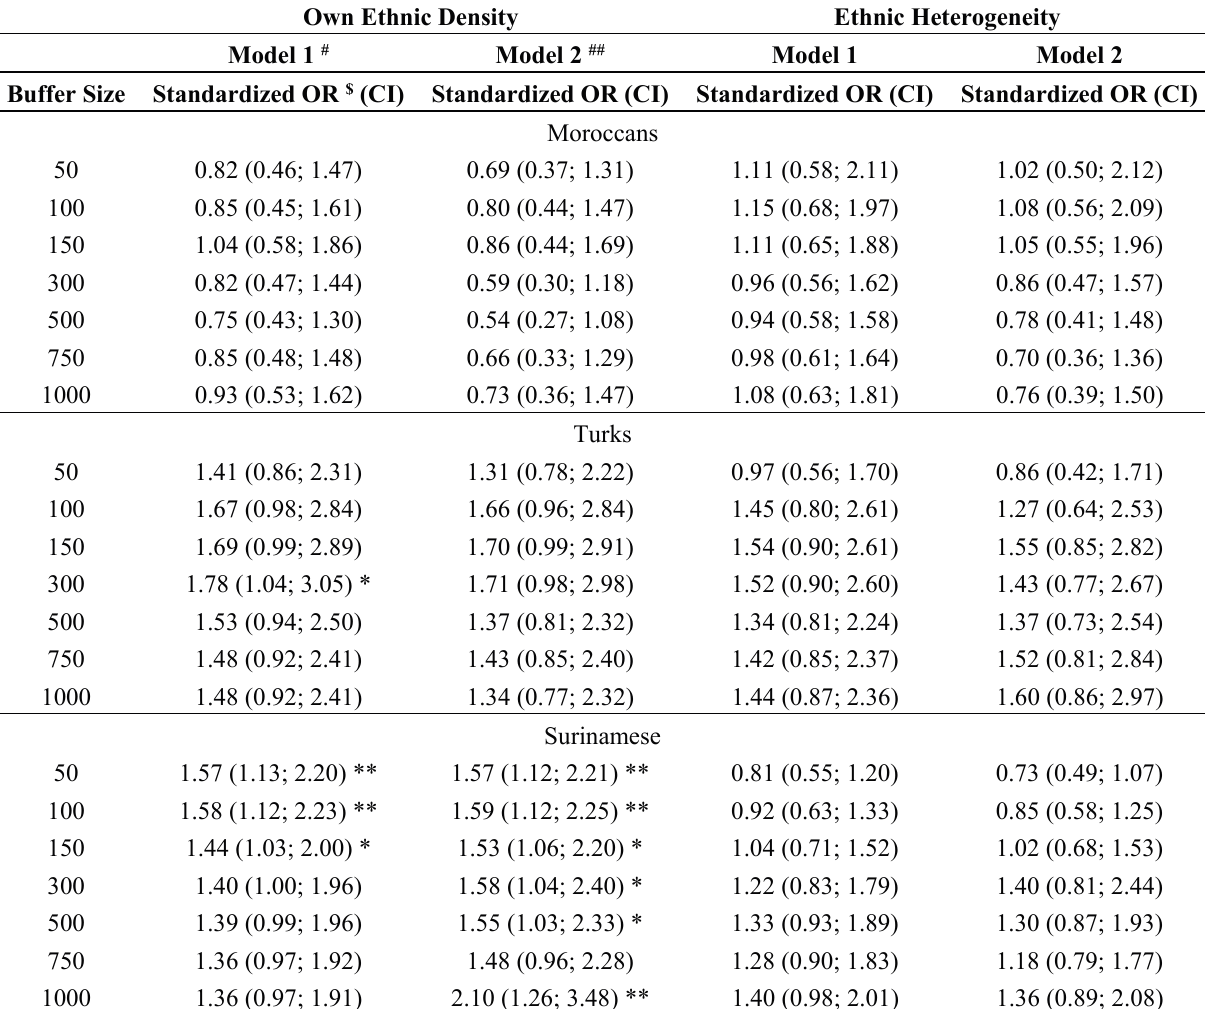
Table 3. Association of own ethnic density and ethnic heterogeneity with poor self-rated health & , per ethnic group and spatial